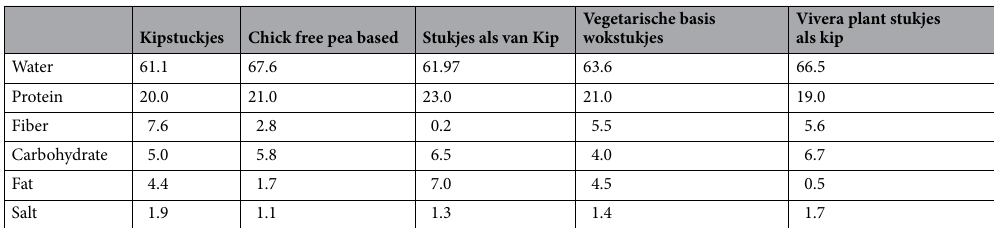
Table 2. Composition of meat analogues.